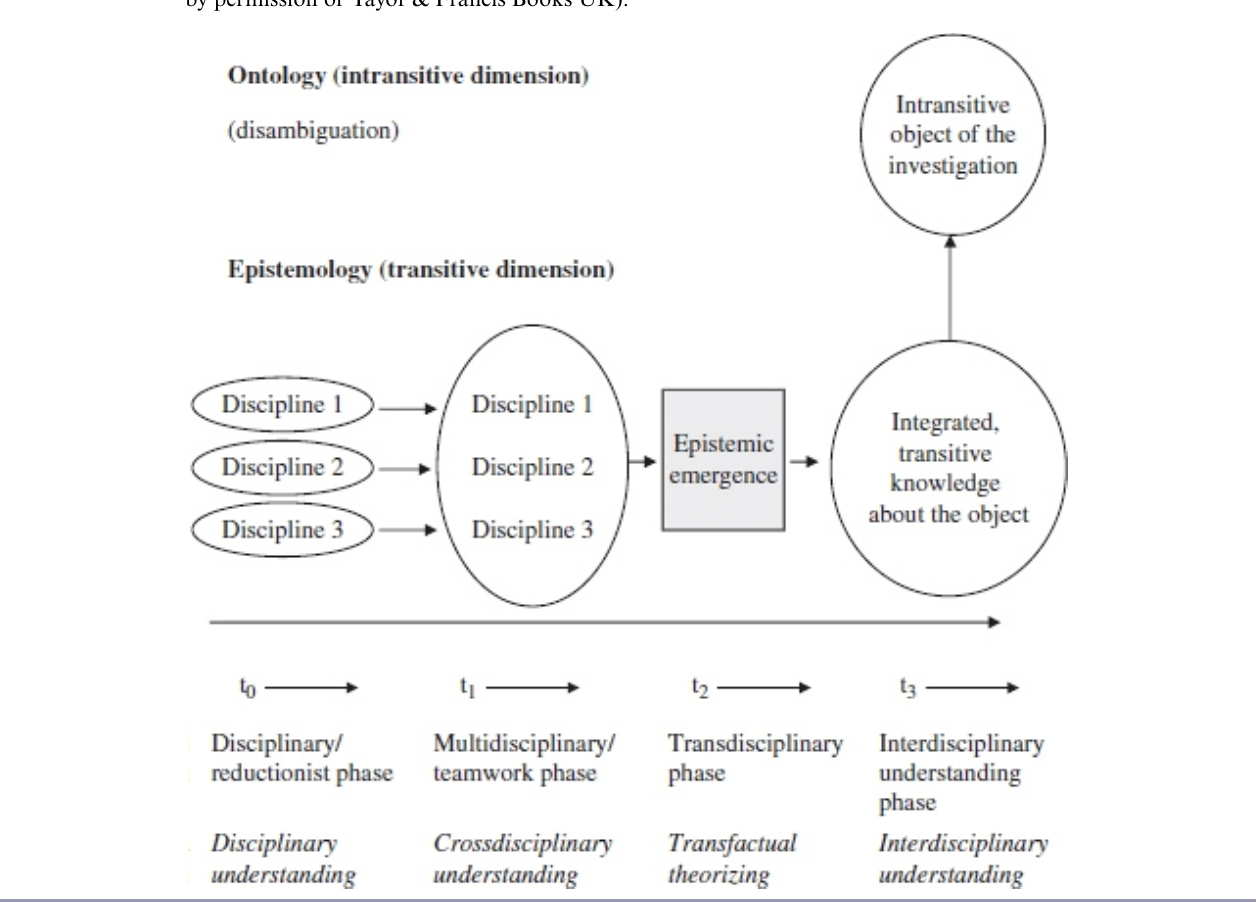
Fig. 2 . Process of conducting interdisciplinary knowledge (Bhaskar et al. 2017, reproduced by permission of Tayor & Francis Books